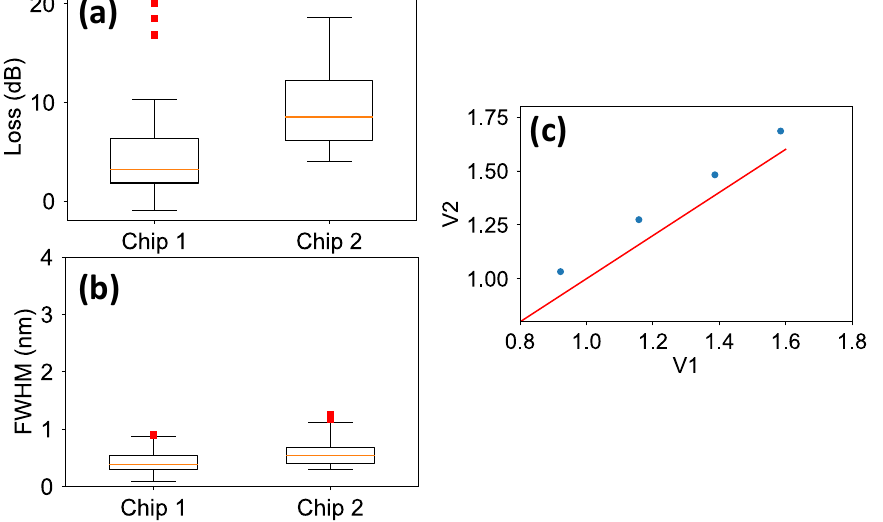
Figure 5. ( a ) Path loss comparison for chip 1 and chip 2. Red squares correspond to outliers and orange lines correspond to the median. ( b ) Full Width Half Maximum (FWHM) of different switches measured on chip 1 and chip 2. ( c ) A plot of voltage on each ring for maximum transmission. Red line corresponds to a 45-degree line where V1 = V2. V1 and V2 corresponds to voltages on the two MRR in a cascaded first order